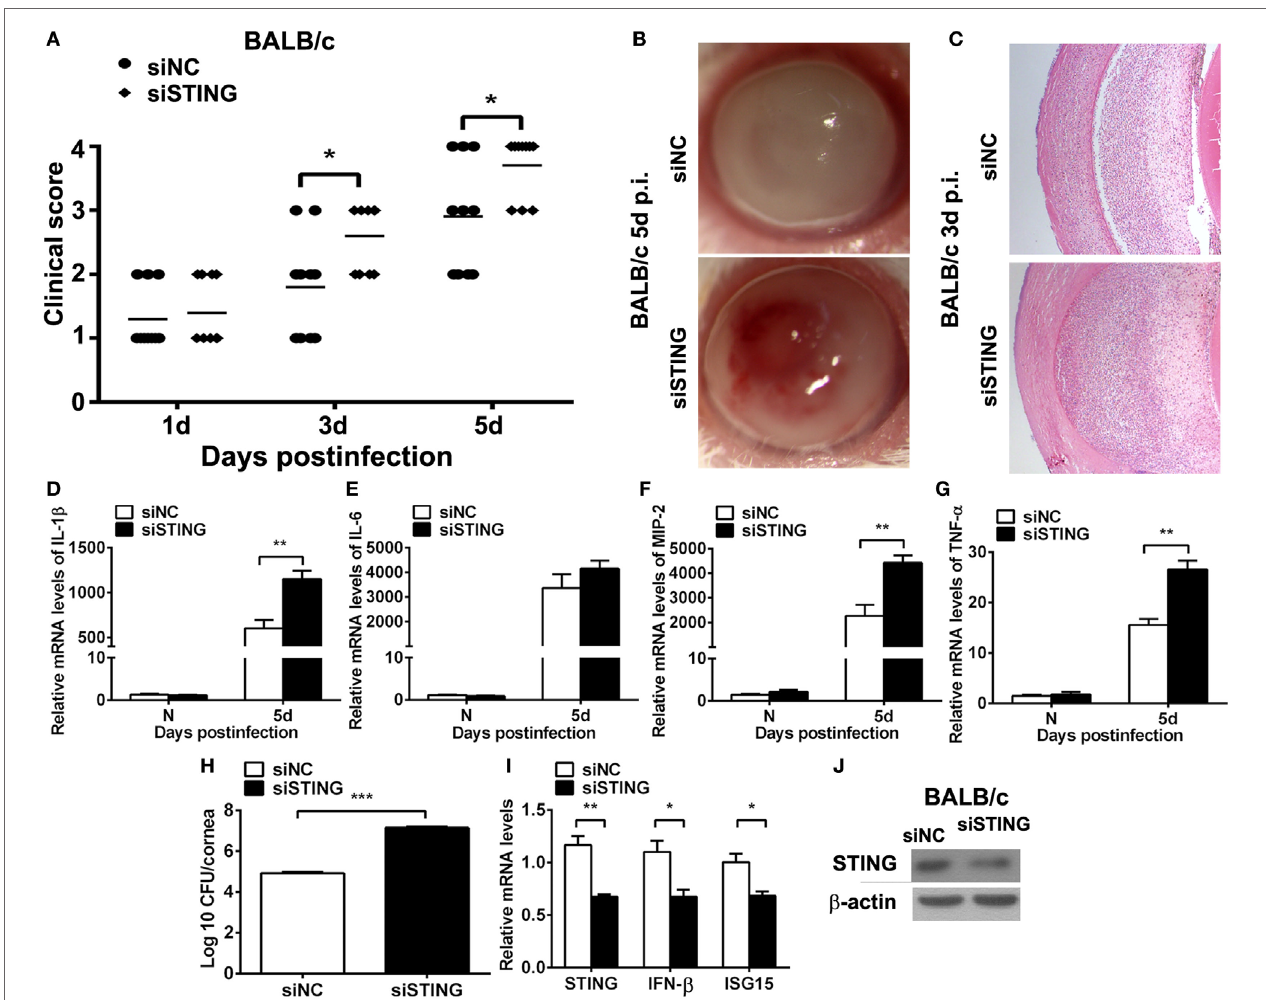
FigUre 2 | Silencing stimulator of interferon genes (STING) accelerated the disease process of Pseudomonas aeruginosa (PA) keratitis. BALB/c mice were subconjunctivally injected with siRNA for mouse STING (siSTING) versus siNC and then infected with PA routinely. (a) Clinical scores indicated the severity of the disease in siSTING- versus siNC-treated groups. (B) Representative slit photographs of mouse corneas at 5 days postinfection (p.i.) displayed more opacity in siSTING- versus siNC-treated mouse cornea (magnification × 10). (c) Hematoxylin–eosin staining was used to detect histopathology of infected cornea at 3 days p.i. in siSTING- versus siNC-treated groups (magnification × 100). (D–g) mRNA levels of interleukin 1 beta (IL-1 β ) (D) , interleukin 6 (IL-6) (e) , macrophage inflammatory protein 2 (MIP-2) (F) , and tumor necrosis factor α (TNF- α ) (g) were measured by using real-time PCR in normal and infected corneas at 5 days p.i. between siSTING- and siNC-treated groups. (h) Bacterial load of infected cornea at 5 days p.i. was measured by plate count in siSTING- versus siNC-treated groups. (i) mRNA levels of STING, IFN- β , and interferon-stimulated gene 15 (ISG15) and protein levels of STING (J) were measured by using real-time PCR and Western blot after treatment with siSTING versus siNC. All data represent one of three independent experiments each using five pooled corneas per time. ** P < 0.01 and *** P <